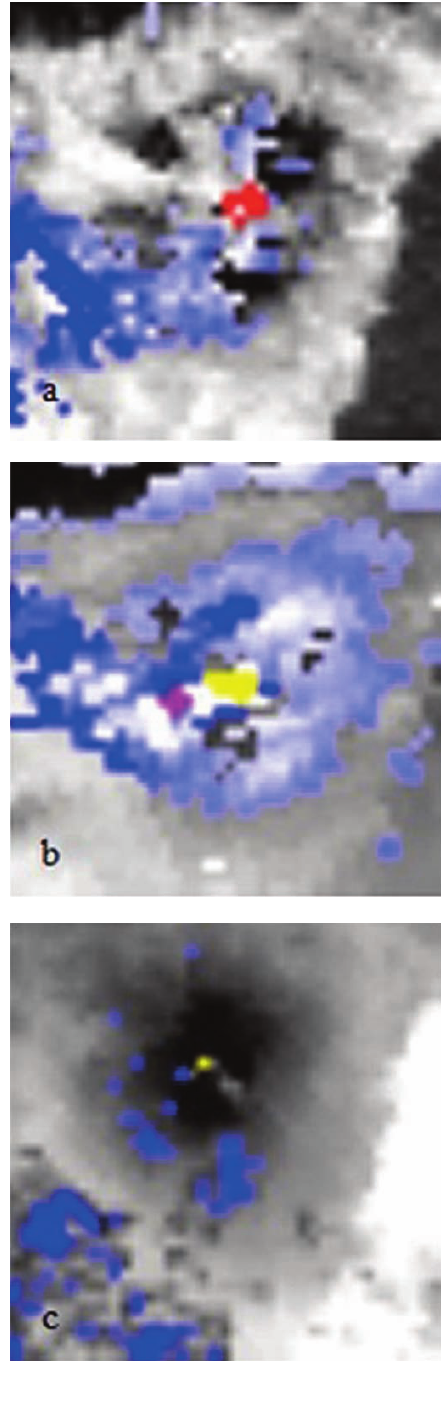
Figure 5 (left). The AVHotRR flow chart. Figure 6 (right). Cloud mask examples for the Etna 2006 eruption. (a) Day time, July 20, 2006. (b) Day time, July 22, 2006. (c) Night-time August 8, 2006. Blue pixels, cloudy areas; red pixels, radiant hot-spots; yellow pixels, saturated